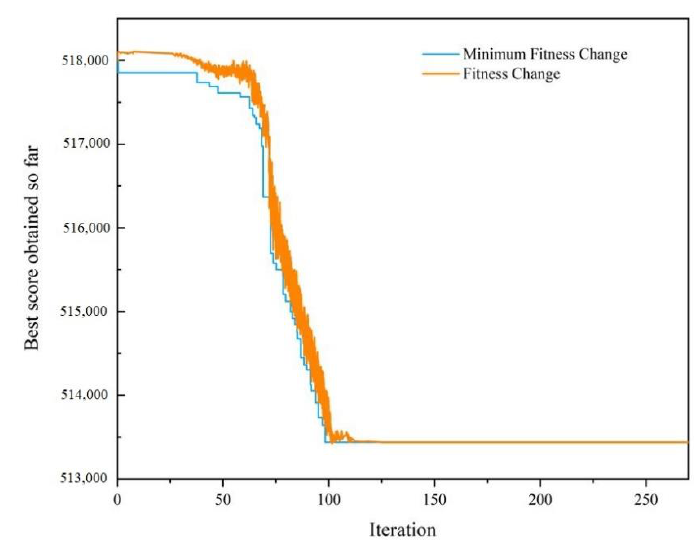
Figure 13. Schematic diagram of iterations of the PSO algorithm.